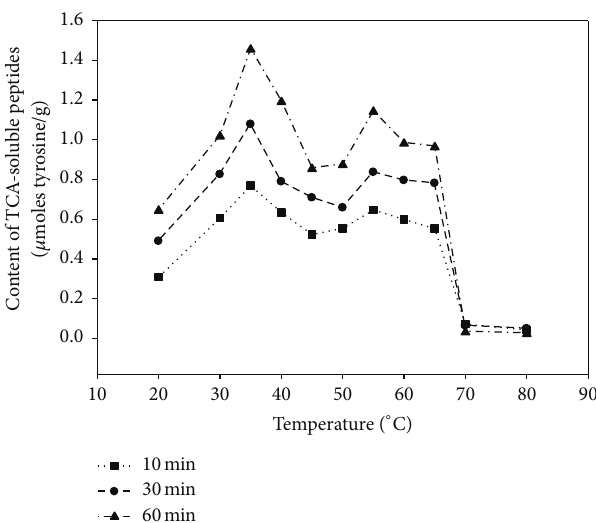
Figure 1: Effect of temperature and incubation time on the soluble peptides in TCA in sols from giant squid ( Dosidicus gigas ).